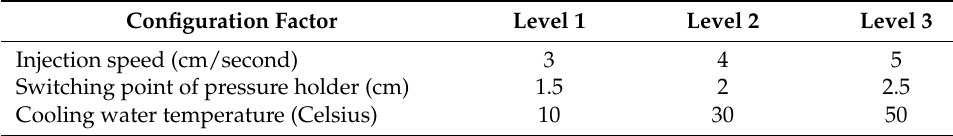
Table 2. The configuration factors for